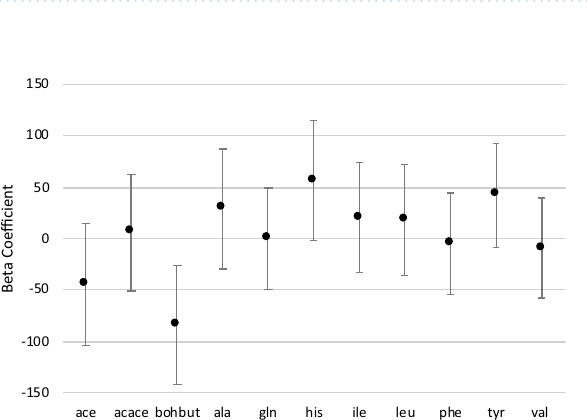
Table 1. FinnTwin12 Spearman correlations of untransformed metabolites and aggression (n=526). Abbreviations: ace acetate, acace acetoacetate, AggComb aggression combined, bohbut 3-hydroxybutyrate, ala alanine, gln glutamine, his histidine, ile isoleucine, leu leucine, phe phenylalanine, tyr tyrosine, val valine. a Aggression is ’Aggression Combined’ variable (which is the mean of parent-12, teacher-12, and teacher-14 aggression ratings).